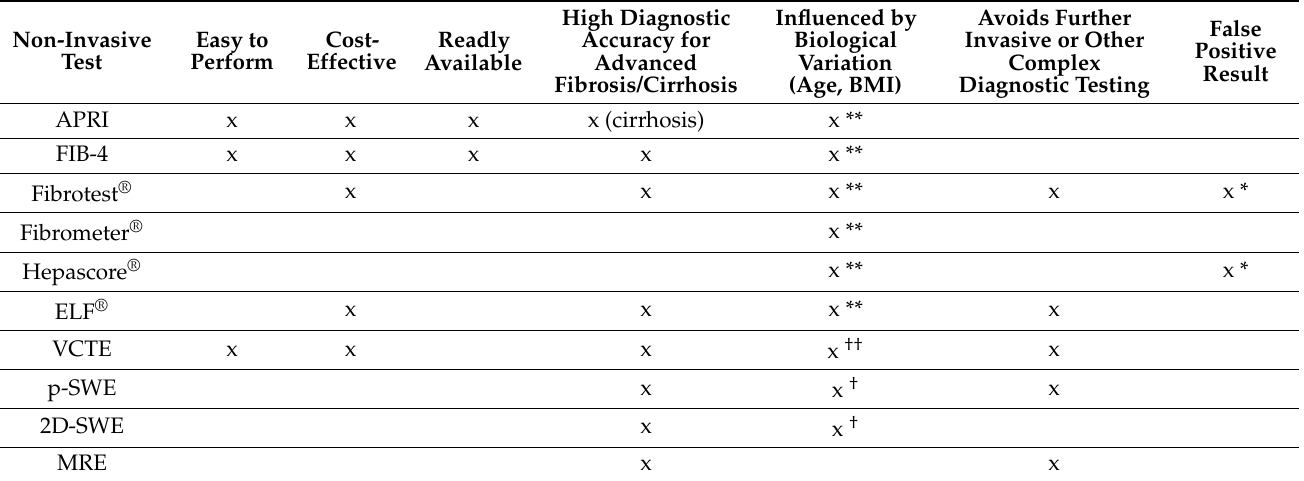
Table 1. Characteristics of the Non-Invasive Tests used in the clinical practice for staging fibrosis in chronic hepatitis